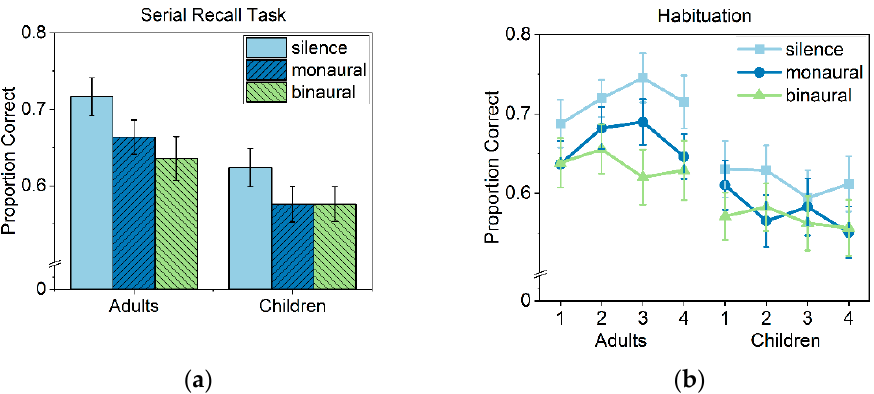
Figure 5. ( a ) Mean proportion correct scores as a function of age group and sound condition. ( b ) Mean proportion of correct scores as a function of age group and as a function of sound condition in four consecutive blocks of four (adults) and two (children) trials. Error bars denote standard errors of the mean.